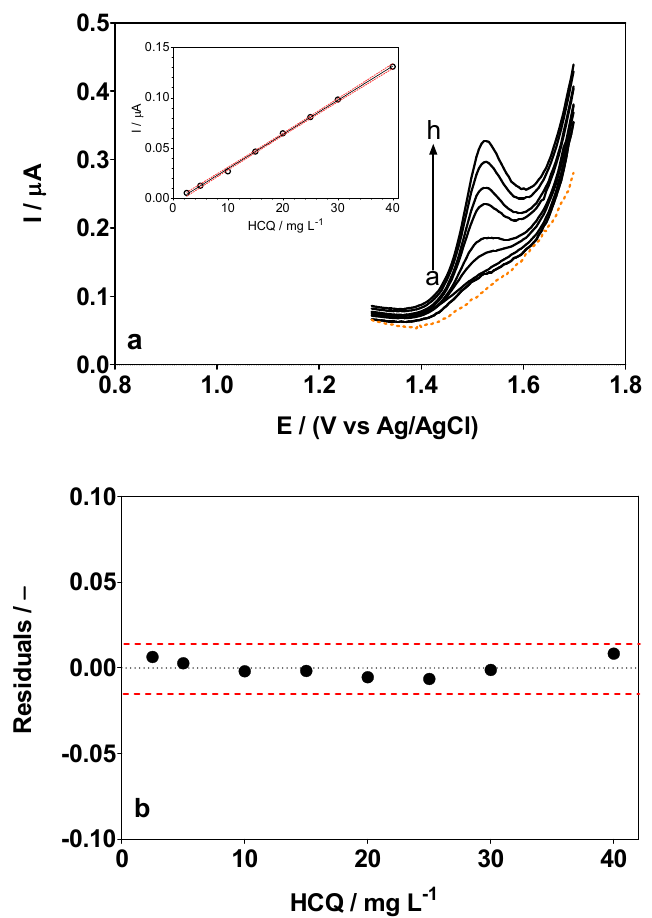
Figure 1. ( a ) DPV curves for electrochemical cork-graphite sensor in acidified sample of river water sample by adding well-known volumes (HCQ solution (10 mM)) to obtain: (a) 2.5 (b) 5, (c) 10, (d) 15, (e) 20, (f) 25, (g) 30, (h) 40 mg L −1 . Blank is the red dashed line. Inset: Plot of electrochemical responses, in terms of current, as a function of HCQ concentration. ( b ) Graphic representation of the residual’s behavior, which confirms the linearity of the calibration curve.